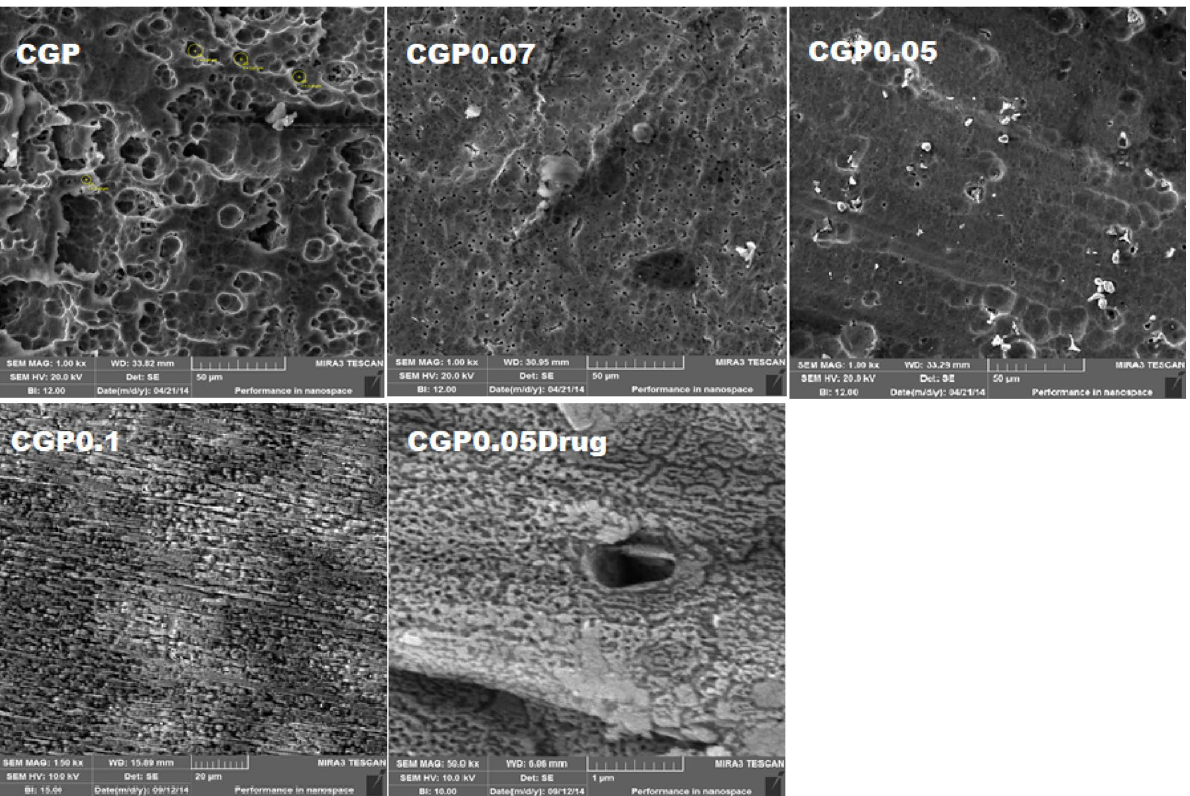
Figure 4. SEM micrographs of CGP hydrogel